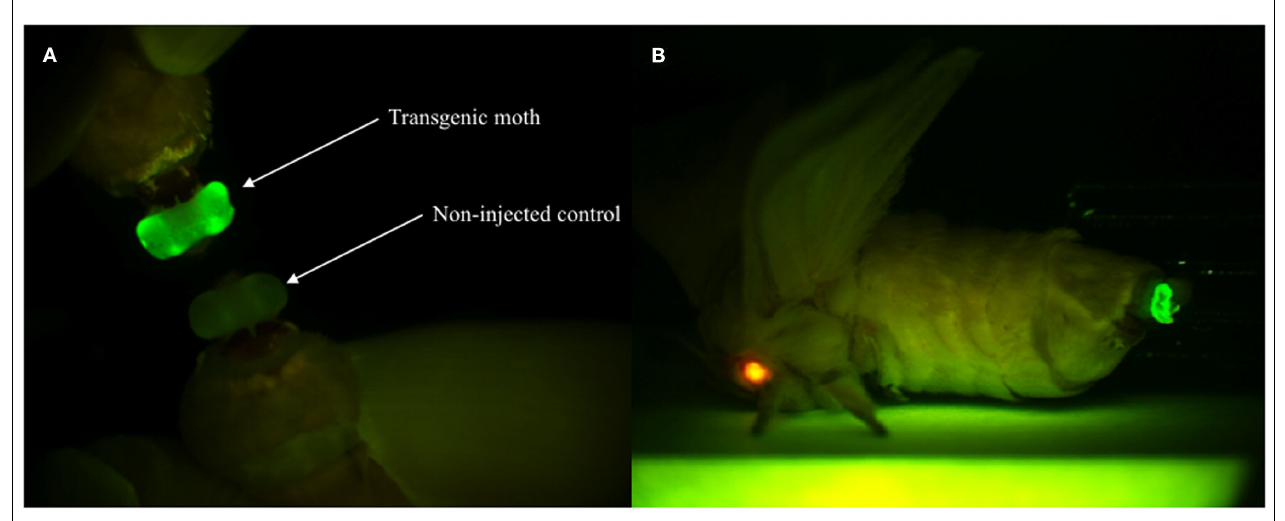
genes via whole-body fluorescence imaging. Red fluorescence is derived from DsRed expressed in the compound eye and green fluorescence is derived from EGFP expressed in the PG of the transgenic B. mori